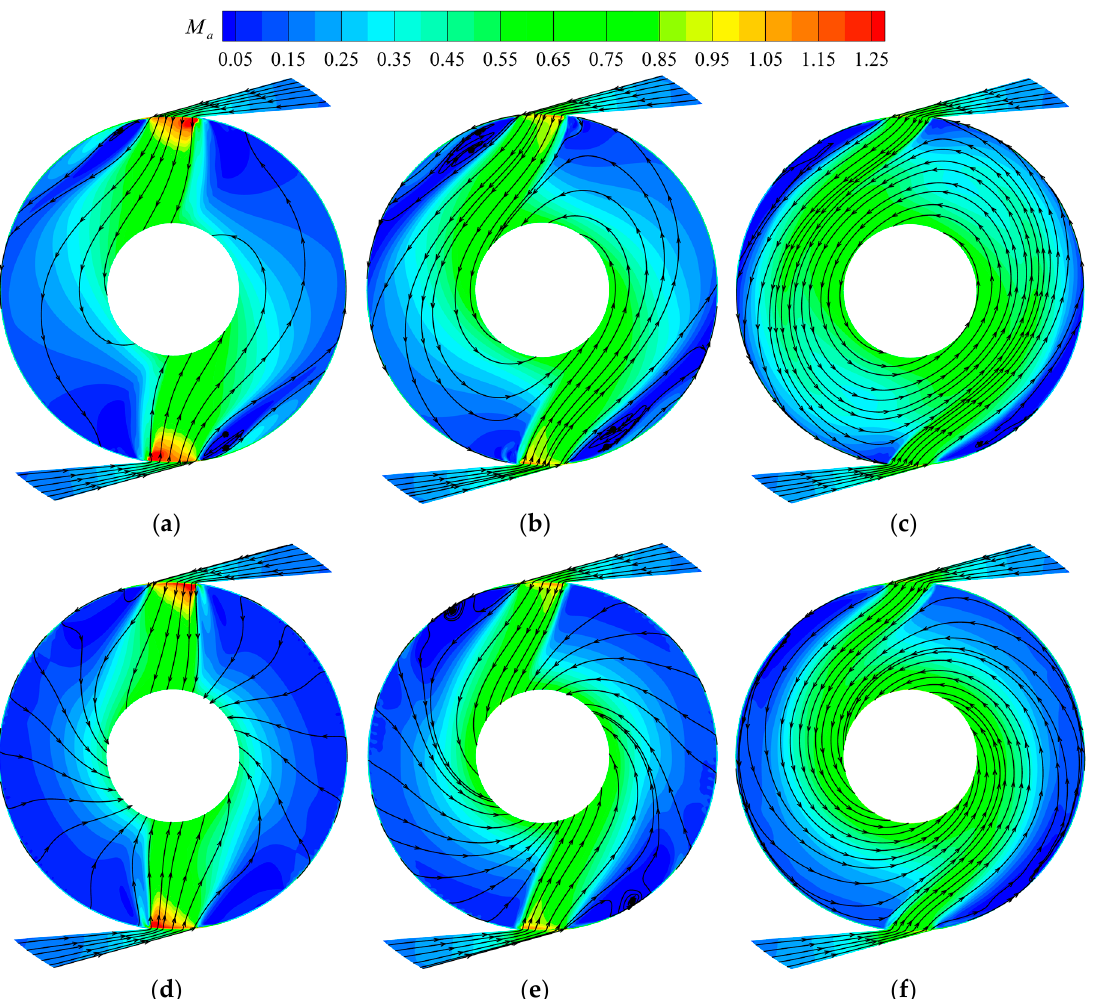
Figure 15. Mach number contours and streamlines on the mid-sections of DCs 1 and 3 for the one-to-many turbine cases with different disc spacing distance at 30,000 r/min: ( a ) DC1 for Case 1-0.3; ( b ) DC1 for Case 1-0.5; ( c ) DC1 for Case 1-1; ( d ) DC3 for Case 1-0.3; ( e ) DC3 for Case 1-0.5; and ( f ) DC3 for Case 1-1.